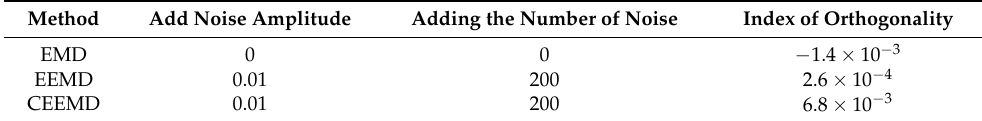
Table 6. Comparison of indicators for signal decomposition.